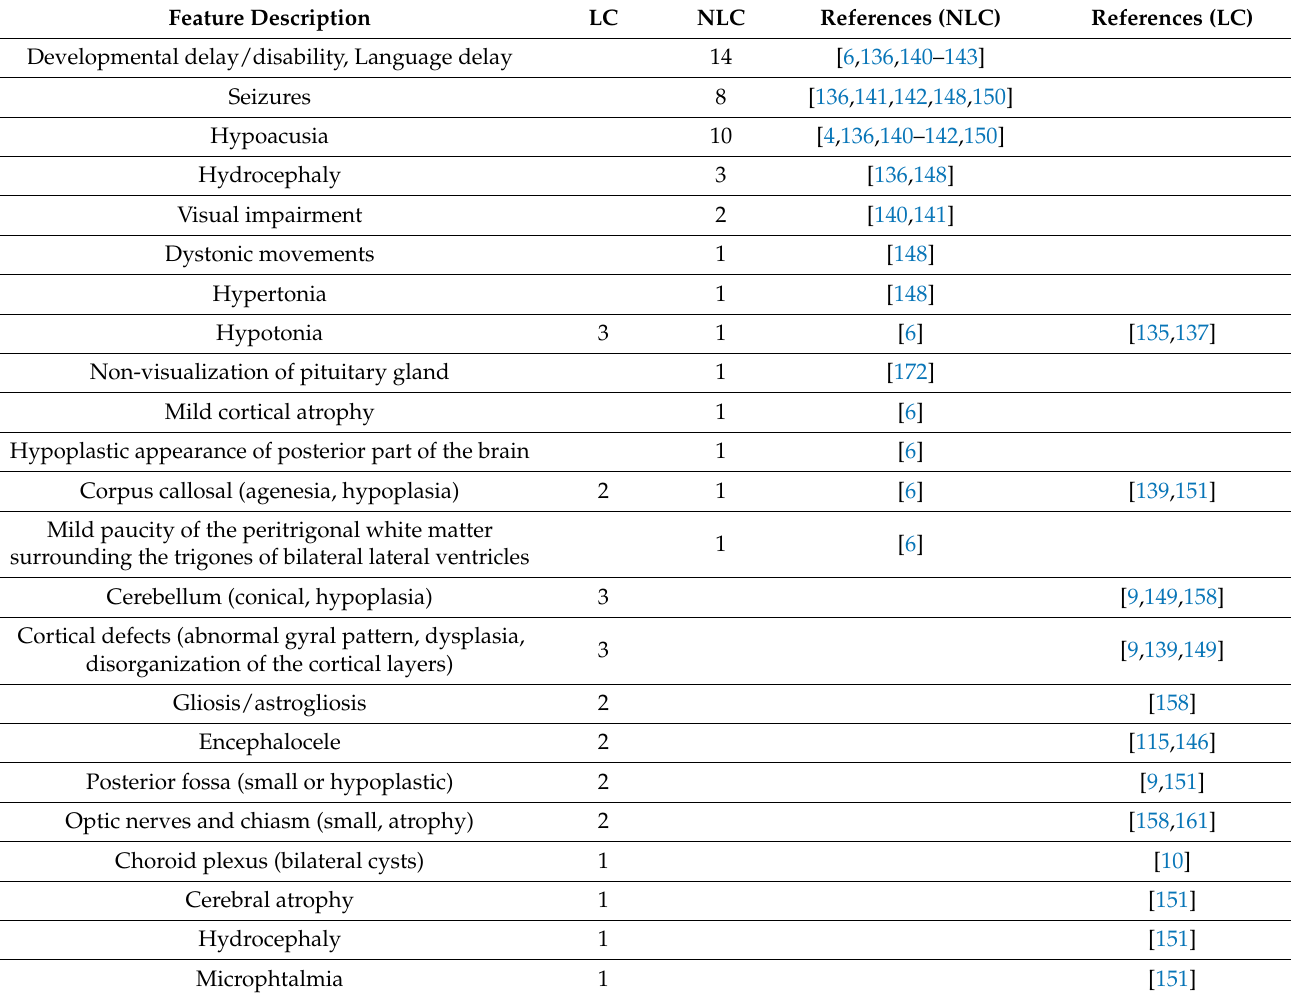
Table 7. Neurological defects in Raine